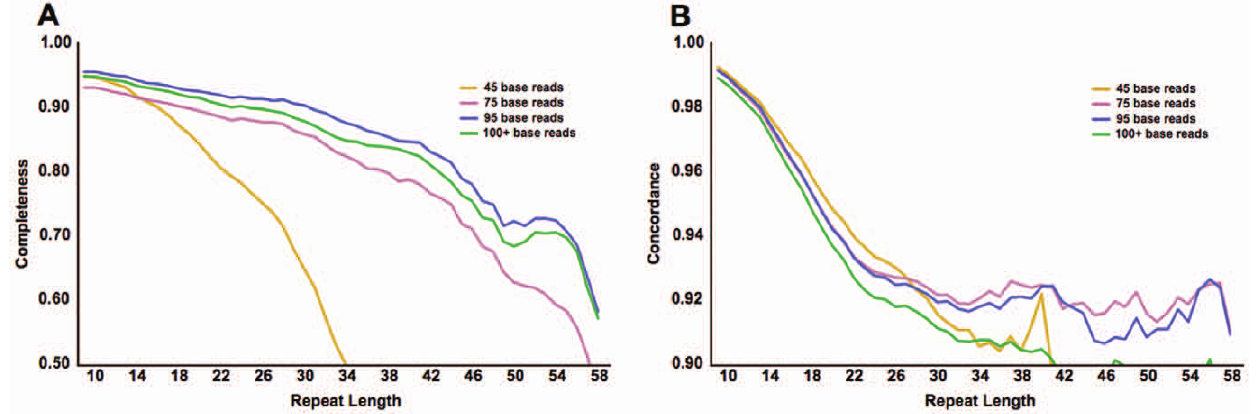
Figure 1. The completeness and internal concordance of microsatellite repeat genotypes in the Drosophila genome. The plotted values are the mean (A) completeness (fraction of repeats with at least two reads passing filtering criteria) and (B) concordance for the genomes in the DGRP panel, grouped by read length. Data have been smoothed for clarity (unweighted mean with window size 6 2 bases). For this initial analysis, only a single matching base on each side of the repeat was required for a read to be scored.